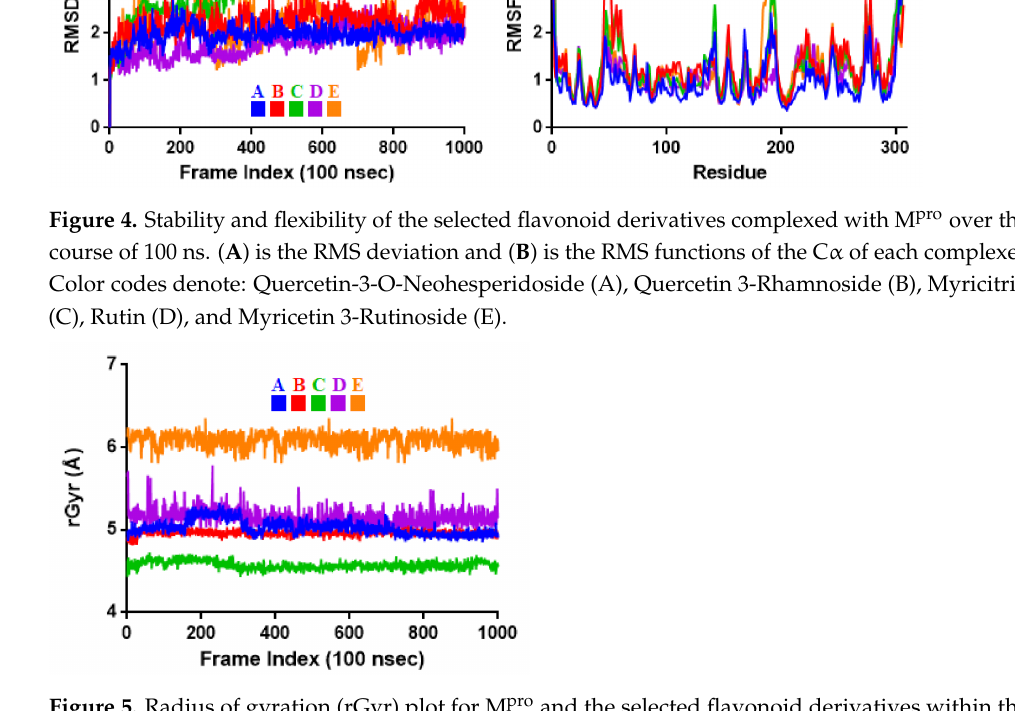
Figure 5. Radius of gyration (rGyr) plot for M pro and the selected flavonoid derivatives within the simulation time of 100 ns. Color codes denote: Quercetin-3-O-Neohesperidoside (A), Quercetin